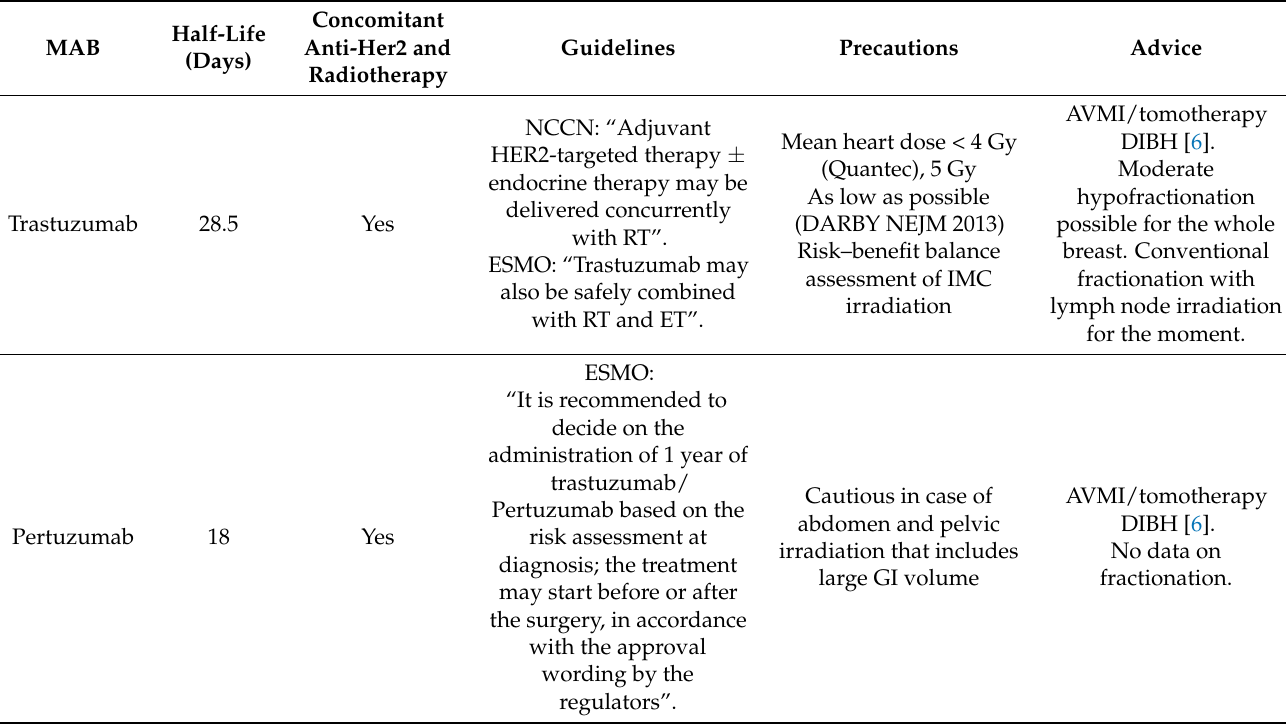
Table 2. Guidelines, precautions, and advice for humanized monoclonal antibody (MAB) targeting